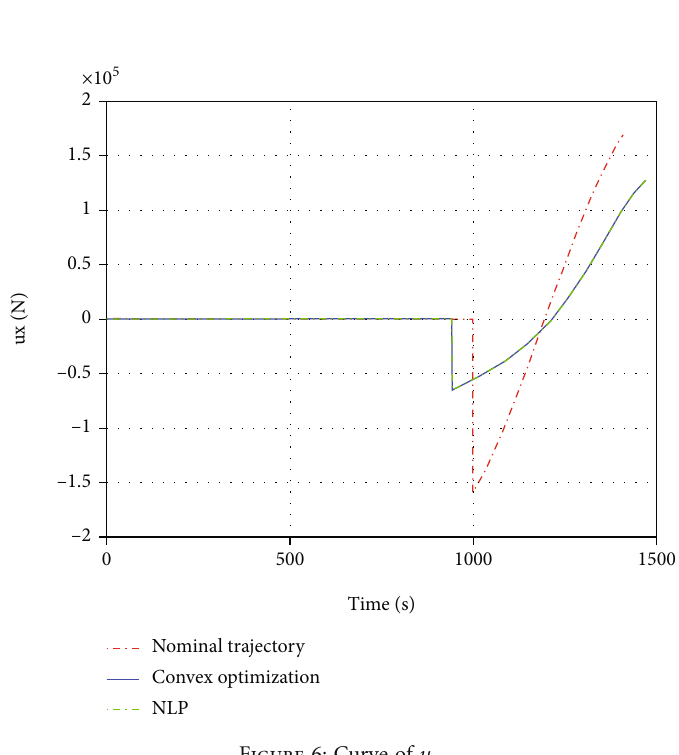
Figure 6: Curve of u